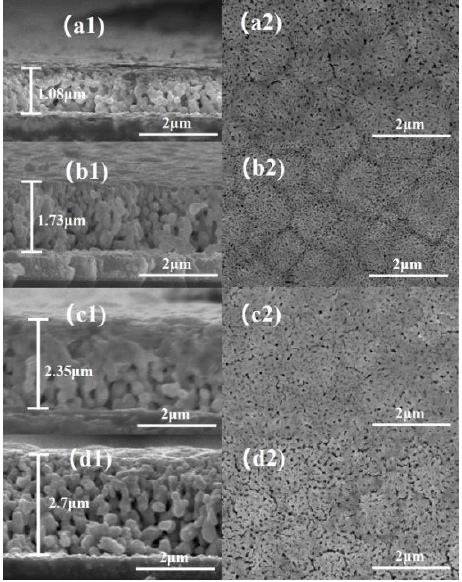
Figure 1. ( a1 – d1 ) Cross-sectional and ( a2 – d2 ) top view SEM images of CdTe thin films grown on FTO